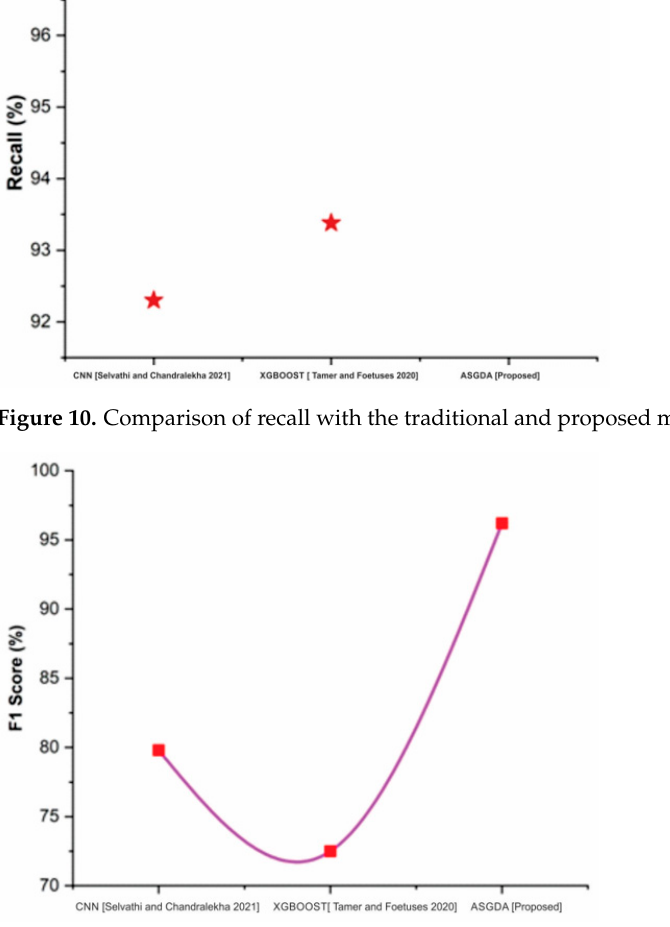
Figure 11. Comparison of F1-score with the traditional and proposed method [42,43]. Table 1. Comparison of traditional methods with the proposed method.